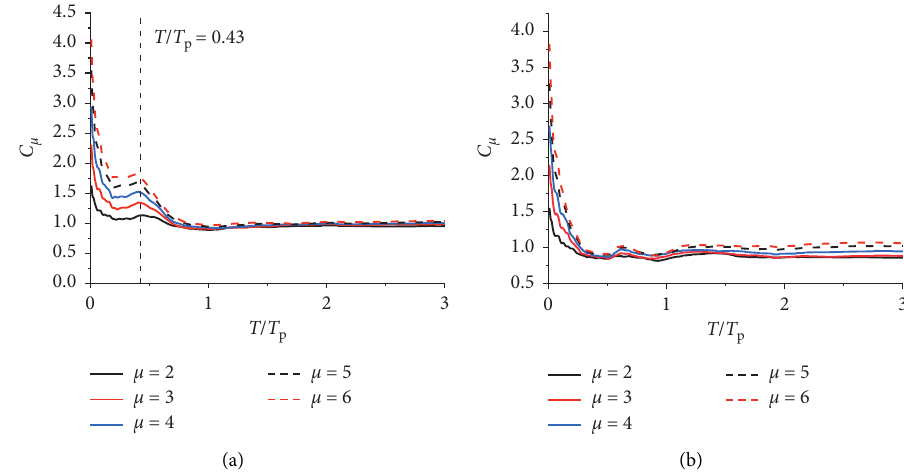
Figure 7: The mean inelastic displacement ratios for the (a) original ground motions and the (b) pulse-removed pars with the horizontal axis normalized by the pulse period ( T p